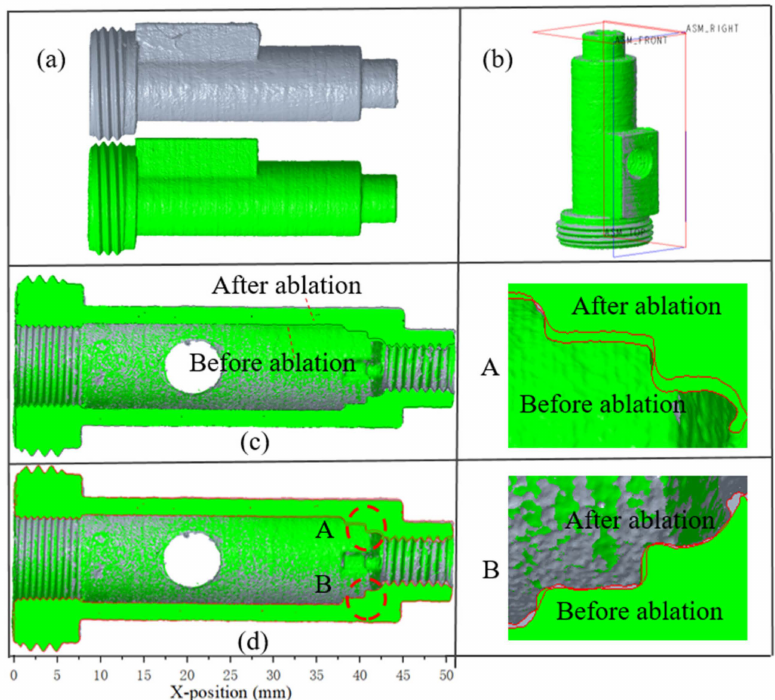
Figure 5. The 3D CT models of the engines. ( a ): the motors before and after ablation; ( b ): Overlay picture; ( c , d ): cross-sectional view, ( c ) is unmarked contour line and ( d ) is marked contour line; (A,B): detail diagram at the